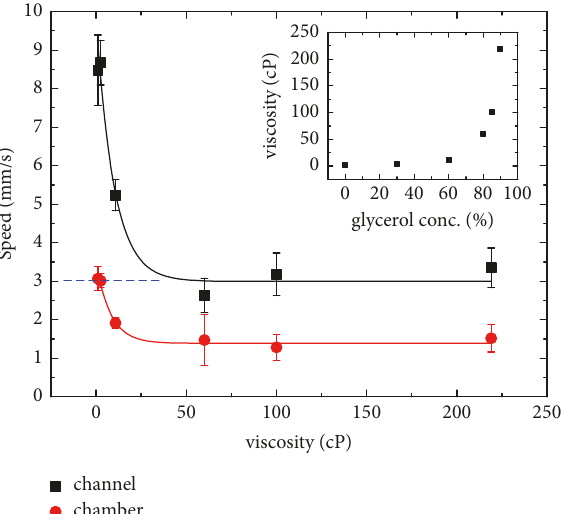
Figure 4: Speed of a beads evaluated in the center of the microfluidic device, in the channel (black data) and in the chamber (red data), plotted as function of the viscosity of the carrier liquids. The reported speeds are the averaged results of data for at least 5 beads and the error bars are the related standard deviation. The liquid viscosity was varied by different mix of water and glycerol (see inset).